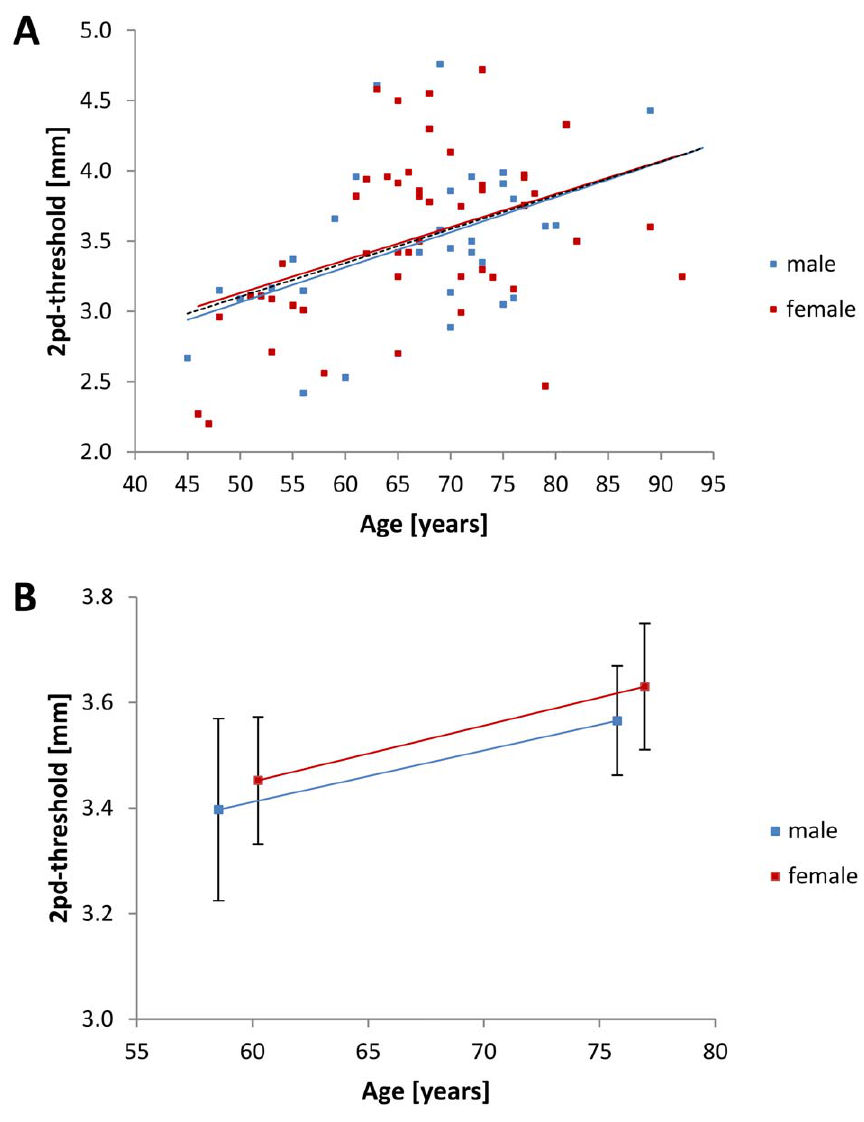
Figure 2. Development of tactile performance in later life. A. Individual two-point discrimination thresholds (i.e., inverse tactile acuity) are depicted for male (blue squares, N=31) and female (red squares, N=48) subjects. Trend lines are inserted for male (solid blue), female (solid red), and all subjects (dashed black). Tactile acuity declined with increasing age (Pearson correlation, N=79, r=0.430, p # 0.001). B. Group data for tactile performance (i.e., two-point discrimination threshold) for younger adults (left squares; females: N=29, 60.24 6 7.07 years; males: N=15, 58.53 6 7.62 years) and older adults (right squares; females: N=20, 76.95 6 5.94 years; males: N=17, 75.76 6 6.71 years). There was no significant interaction of the subjects’ age and gender with their tactile acuity (AGE*GENDER: F (1,31) =17.535; p # 0.001). Black bars indicate